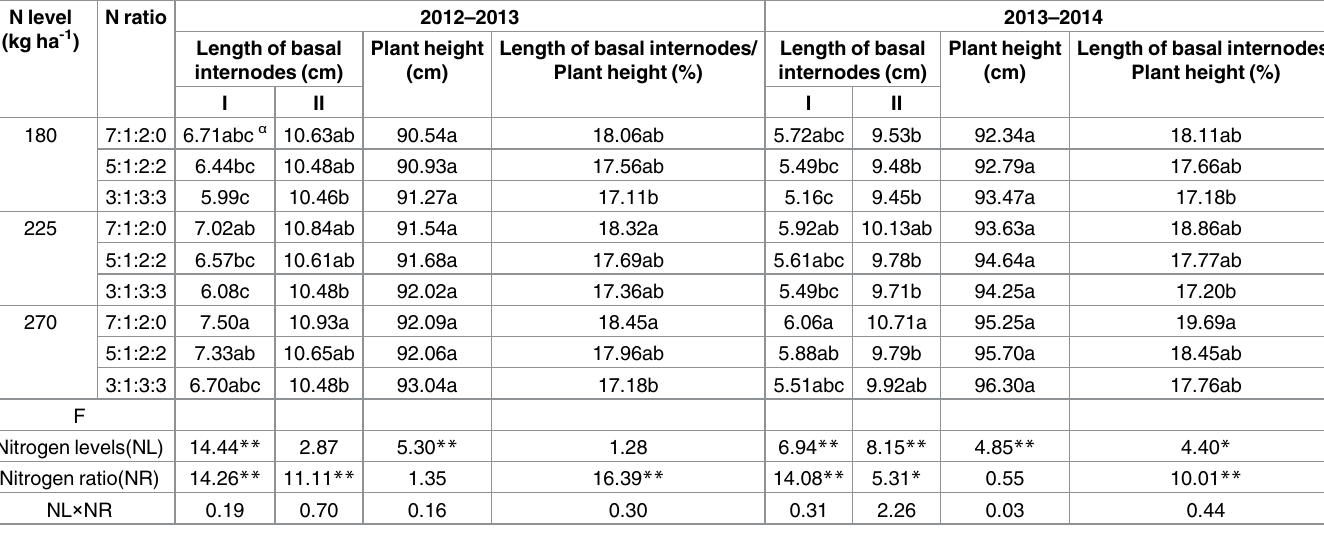
Table 3. Effect of nitrogen levels and ratios on plant height and length of basal